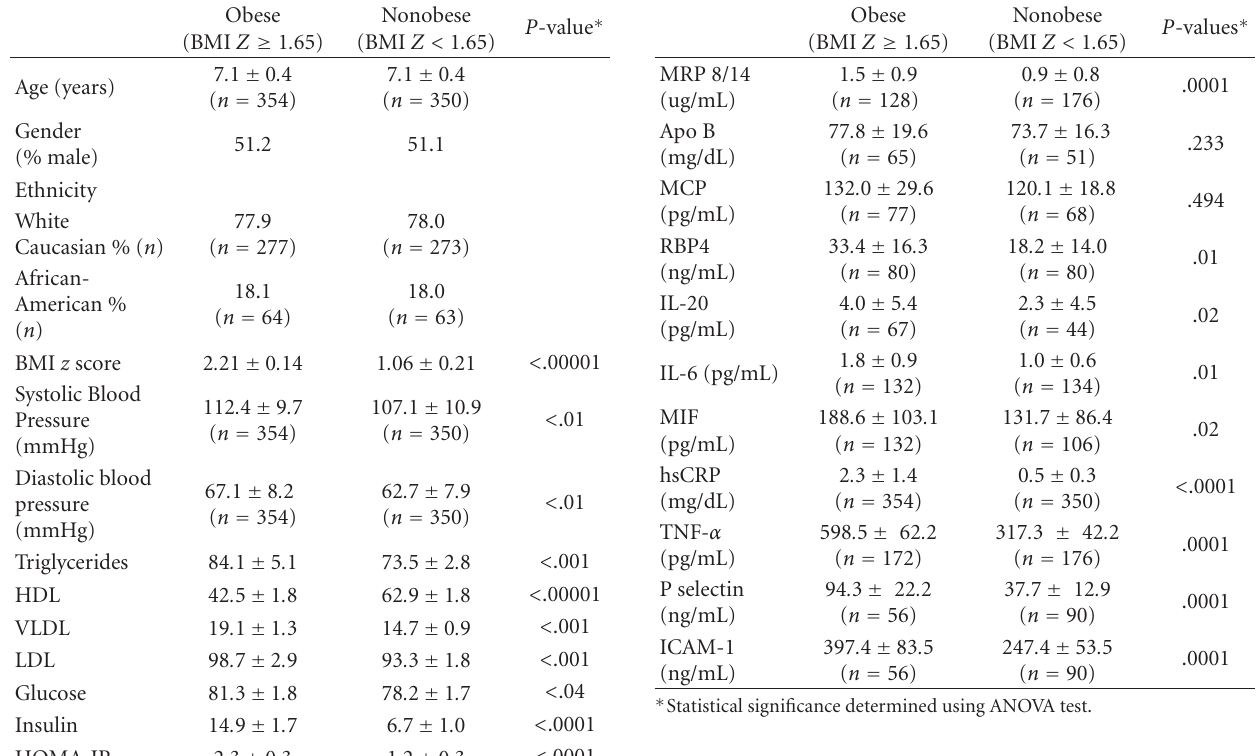
Table 1: Demographic characteristics of obese and nonobese children.